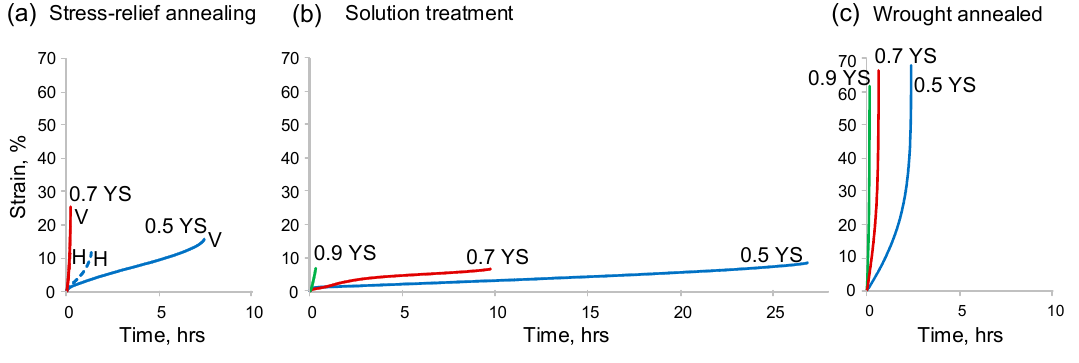
Figure 7. Creep diagrams of the ( a ) SR, ( b ) ST, and ( c ) wrought annealed IN265 alloys at 760 °C (1400 °F).